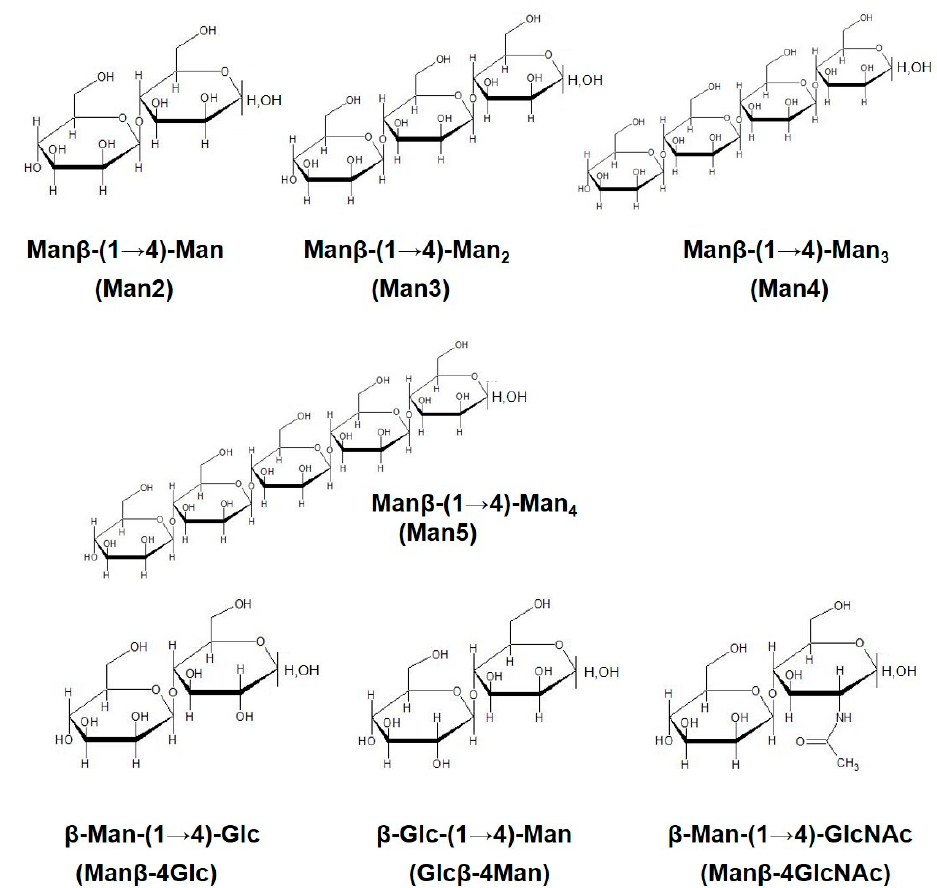
Figure 1. The structure of the tested mannooligosaccharides. Tested samples include β -Man-(1 → 4)-Man (Man2), β -Man-(1 → 4)-Man2 (Man3), β -Man-(1 → 4)-Man3 (Man4), β -Man-(1 → 4)-Man4 (Man5), β -Man-(1 → 4)-Glc (Man β -4Glc), β -Glc-(1 → 4)-Man (Glc β -4Man), β -Man-(1 → 4)-GlcNAc (Man β -4- GlcNAc).